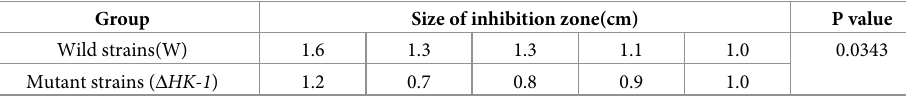
Table 4. Statistical results of inhibition zone size